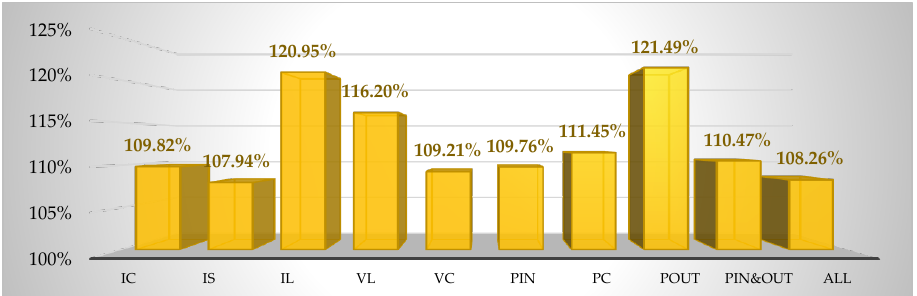
Figure 15. Average accuracy comparison of all input signals.